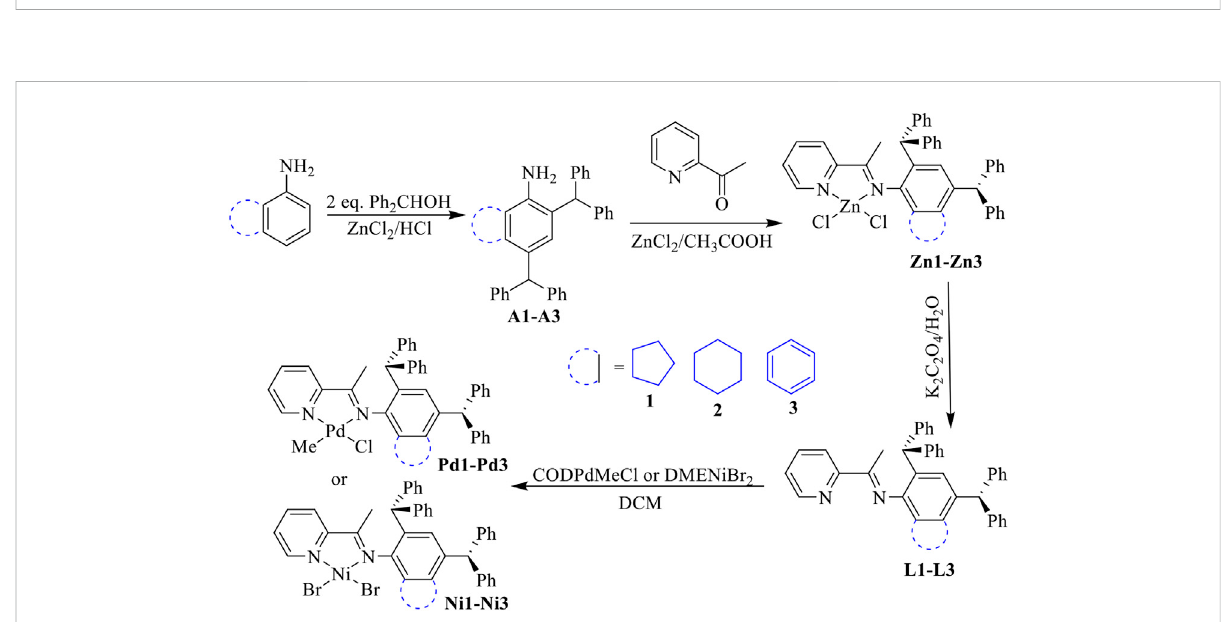
SCHEME 1 Synthesis of unsymmetrical dibenzhydryl iminopyridine ligands with benzocycloalkyl or naphthyl moieties and the corresponding